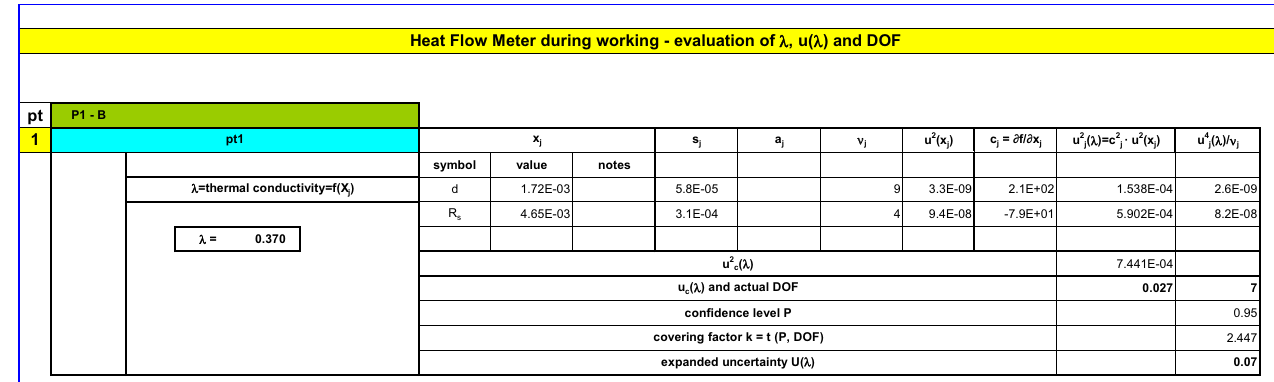
Table 5. Final results of λ with their associated combined uncertainties and